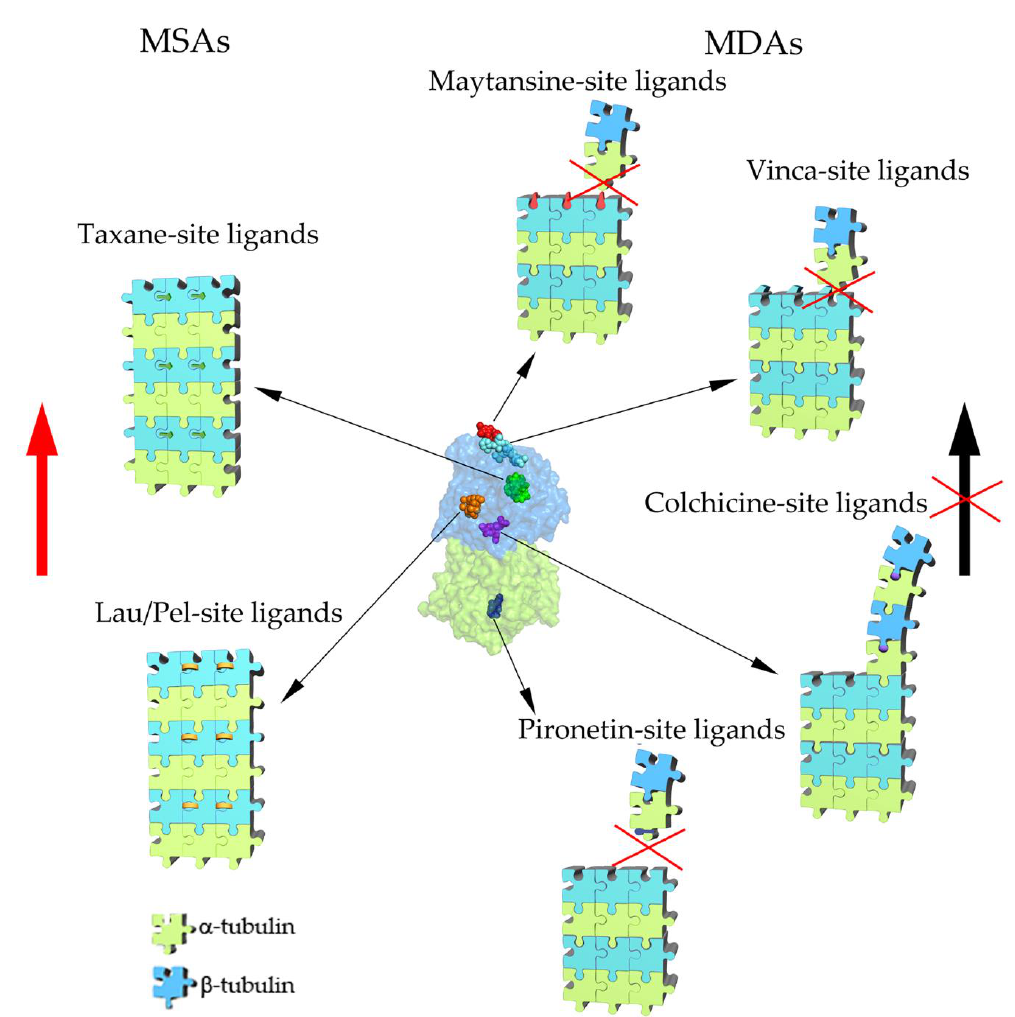
Figure 2. Location of the microtubule-targeting agent (MTA)-binding site on tubulin and the MTA mechanism of action. Microtubule-stabilizing agents (MSAs) (taxane and laulimalide / peloruside-site ligands) promote microtubule (MT) growth (red arrow) by stabilizing lateral contacts between neighboring heterodimers (see text). MDAs inhibit MT growth and destabilize MTs (crossed out black arrow) by inhibiting addition of new heterodimers at the MT plus end (maytansine- and pironetin-site ligands) or by inhibiting transition of heterodimer structure to straight conformation (colchicine- and vinca-site ligands) (see text).